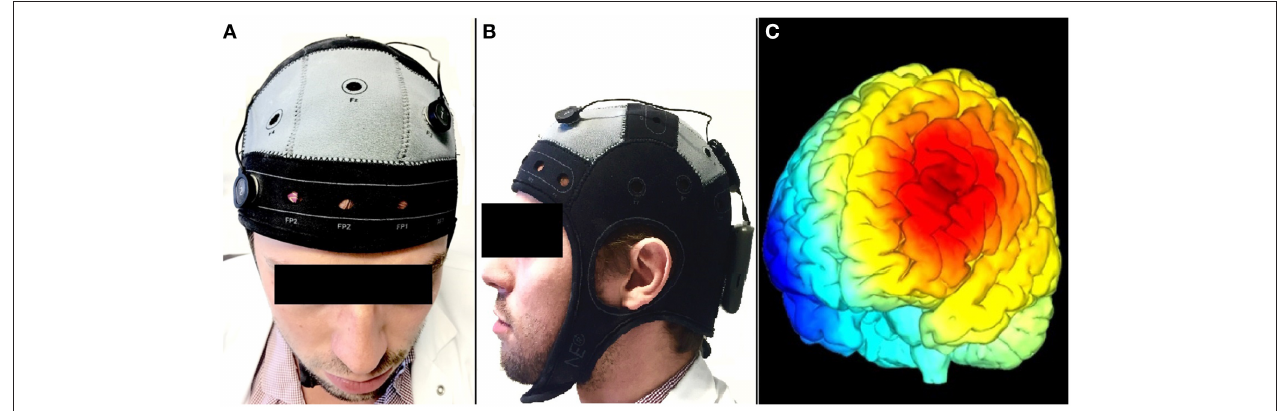
FIGURE 1 | An illustration of the tDCS montage in this study (Starstim, Neuroelectrics, Barcelona, Spain); with a cathode over AF8 (A), an anode over F3 (A,B) according to the international 10–20 EEG system. A simulation of the electric field generated between F3 (in red) and AF8 (in blue) is shown in (C)